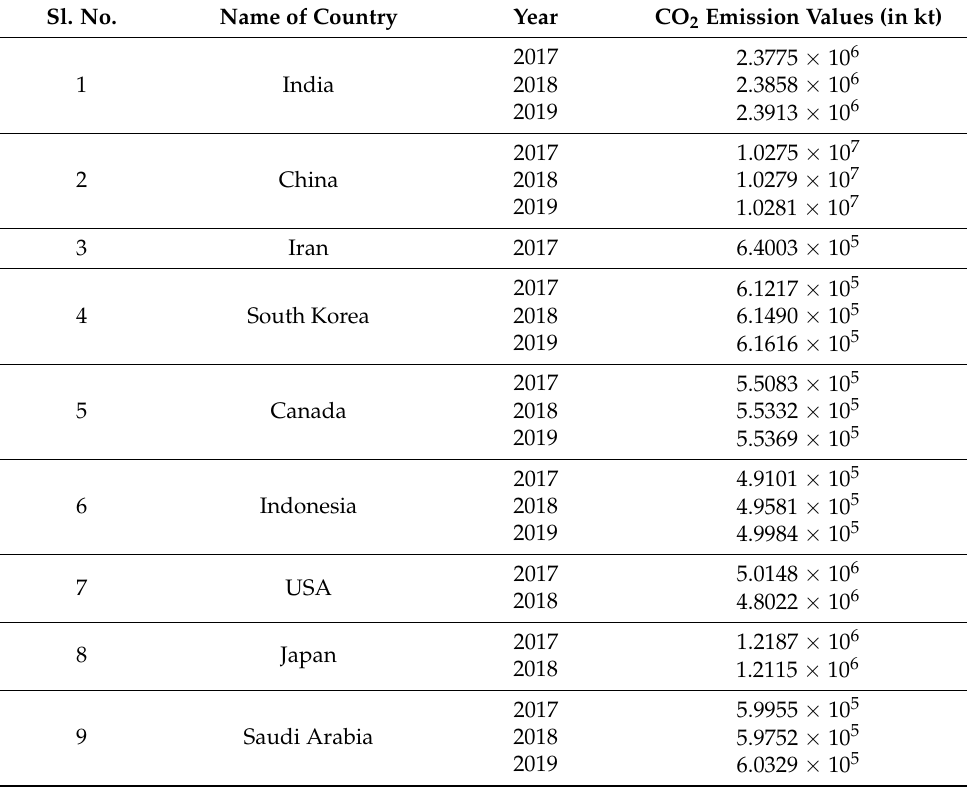
Table 4. Forecasted CO 2 emission values for the year 2017–2019 for Group-1 countries. Sl. No.